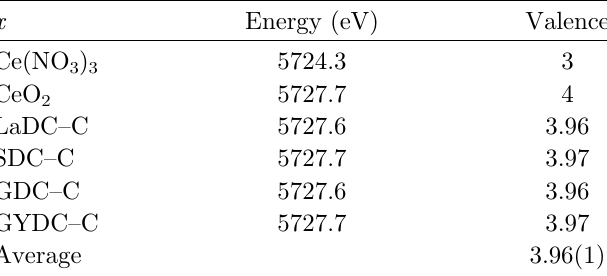
Table 7. Ce(NO ) , CeO and LaDC, SDC, GDC, and 3 3 2 GYDC composite sample powders with 500 (cid:1) C treatment: Ce L -edge XANES spectrum single maximum differential energy shoulders and corresponding Ce valence.